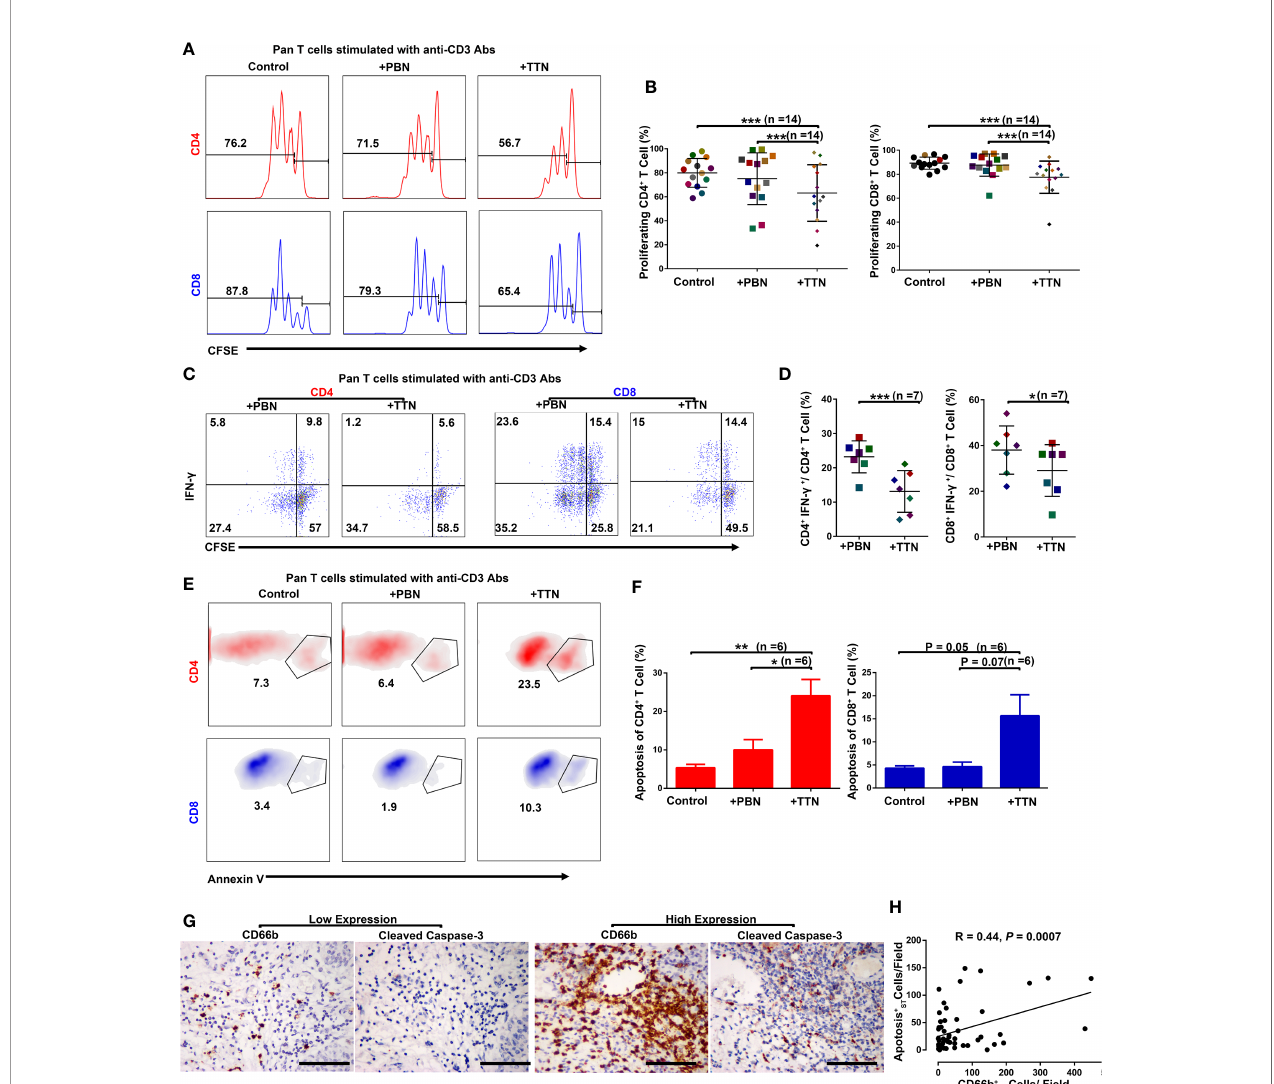
FIGURE 3 | T cell proliferation, apoptosis, and activation in the presence of PBNs or TTNs. In all experiments, autologous T cells were puri fi ed from PBMCs, stimulated with plate-bound anti-CD3/CD28 Abs, and were cultured alone or with PBNs or the tumor cell line T24 supernatant-treated PBNs (TTNs) at a 1:1 ratio for fi ve days. (A, B) Flow cytometric analysis of autologous CD4 + T cells and CD8 + T cells proliferation in the presence of PBNs or TTNs (n = 14). (C, D) Flow cytometric analysis of autologous CD4 + T cells and CD8 + T cells IFN- g production in the presence of PBNs or TTNs (n = 7). (E, F) Flow cytometric analysis of autologous CD4 + T cells and CD8 + T cells apoptosis in the presence of PBNs or TTNs (n = 6). Numbers on histograms or a density plot represented the percentage of T cell proliferation or apoptosis, respectively (A, E) . Numbers in quadrants indicate the percentage of cells in each quadrant (C) . Error bars represent the mean ± SEM. P < 0.05 was considered a signi fi cant difference (Student ’ s t- test, paired parametric test). (G, H) Consecutive sections were used for the immunohistochemical identi fi cation of stromal CD66b + cells and apoptosis makers (Cleaved Caspase-3) in UCB tissues (n= 57). P < 0.05 was considered signi fi cant difference (Spearman ’ s rank correlation coef fi cient test). Representative examples of tumors with either low (top) or high (bottom) expression of neutrophil (CD66b), apoptosis (Cleaved Caspase-3) markers are shown. Scale bar: 100 m m. * P < 0.05; ** P < 0.001; *** P <